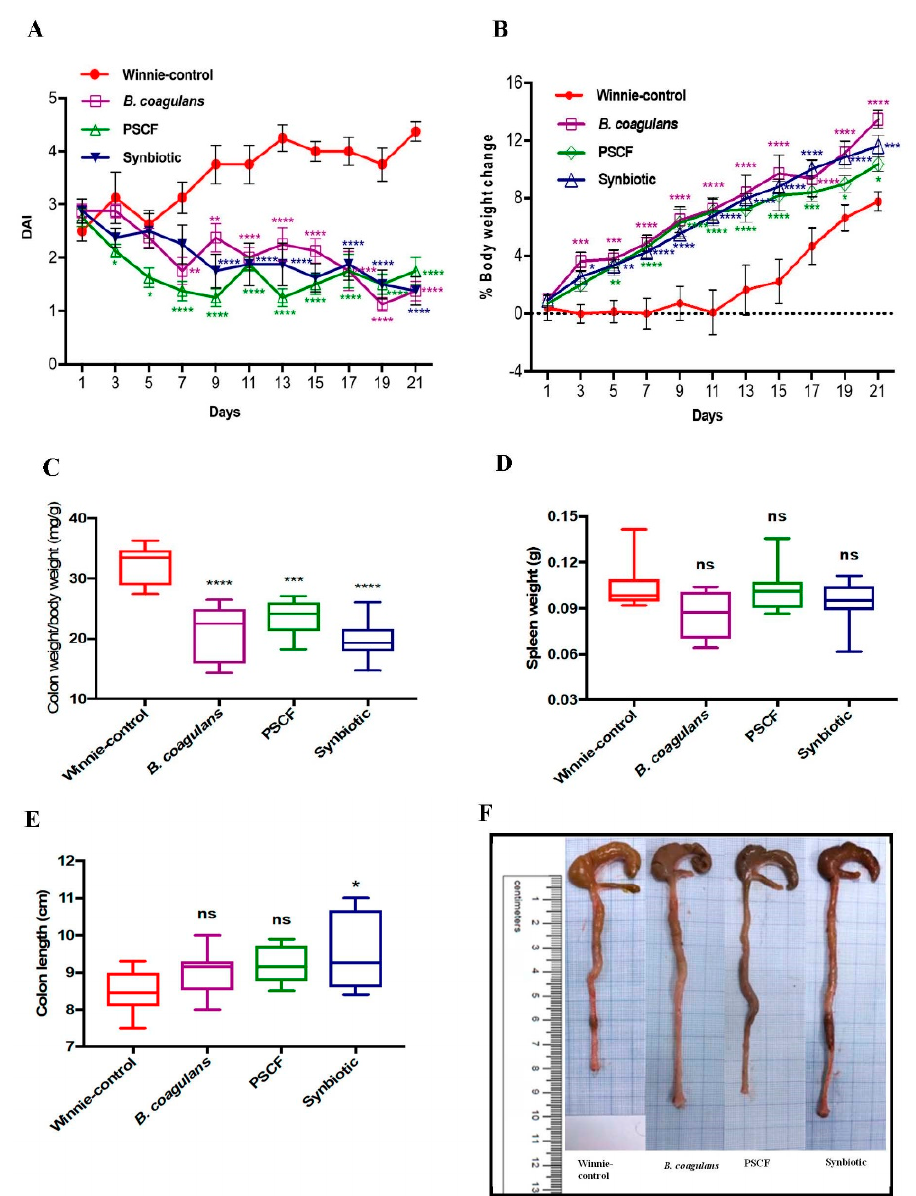
Figure 2. Effect of B. coagulans spores, PSCF and Synbiotic on clinical manifestations in chronic-colitic-Winnie mice. ( A ) Disease Activity Index (DAI), ( B ) % body weight change. Statistical significance among groups evaluated by two-way repeated-measures analysis of variance (ANOVA) * p < 0.05, ** p < 0.01, *** p < 0.001, **** p < 0.0001 vs. Winnie-control group and data expressed as mean ± SEM ( n = 8 per group). Colon weight / body weight ratio ( C ), Spleen weight ( D ), Colon length ( E ) and macroscopic appearance of colon ( F ). Data expressed as mean ± SEM ( n = 8 per group), evaluated by one-way ANOVA followed by Tukey’s Test. NS = non-significant, PSCF-Prebiotic sugarcane fibre.